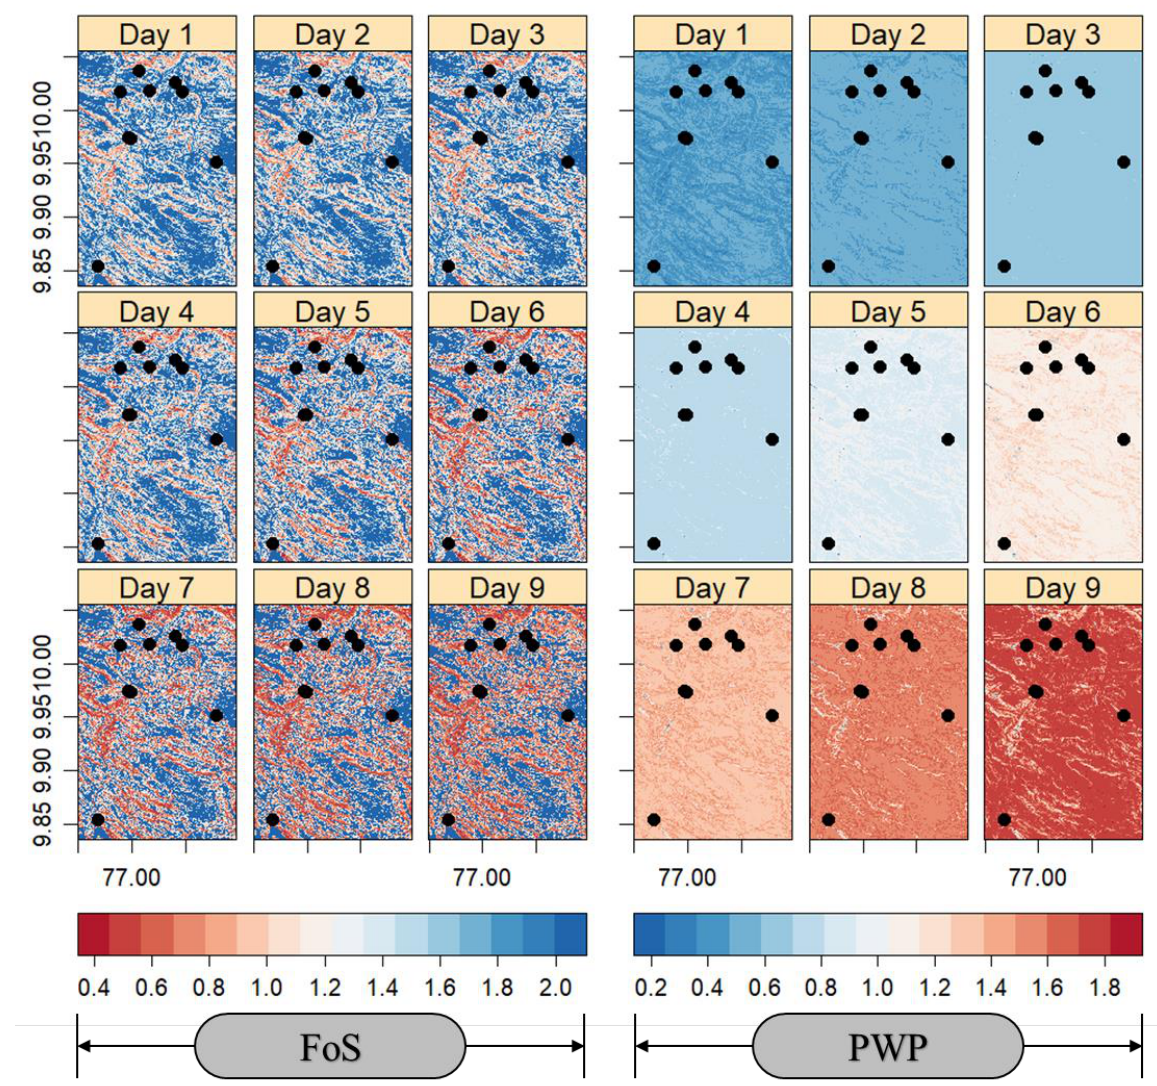
Figure 12. ( Left ) Fall in factor of safety (FoS) in and around the nine landslides for the nine days rainfall period. Day 1 ( top left ) is the plot of FoS at each pixel at the end of a 24-h rainfall period and Day 9 is the FoS at each pixel at the end of a 9-day rainfall period. Red region indicates lower FoS, unstable, areas and blue region indicates higher FoS, stable area. ( Right ): Rise in Pore Water Pressure (PWP) in and around the nine landslides for the nine days rainfall period. Day 1 ( top left ) is the plot of PWP at each pixel at the end of a 24-h rainfall period and Day 9 is the PWP at each pixel at the end of a 9-day rainfall period. Red region indicates higher PWP (relatively unstable), and blue region indicates lower PWP (relatively stable). The black dots indicate the landslide sites. Note that the color keys are reversed for easy demarcation of relatively unstable (~red) areas.